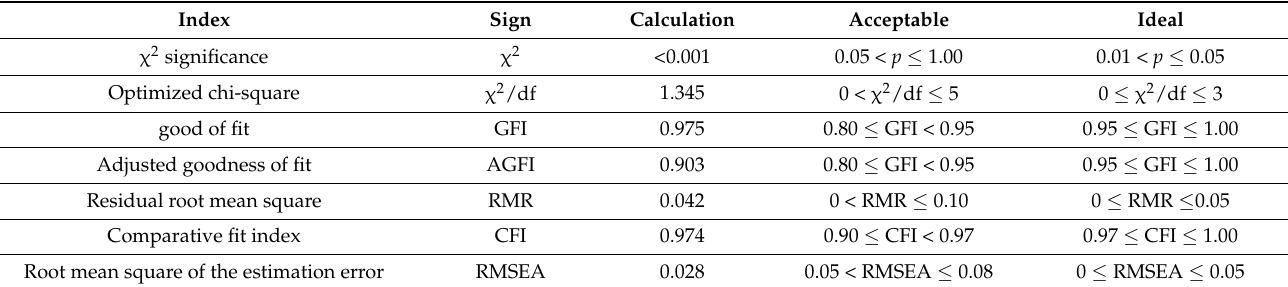
Table 3. The goodness of fit criteria of the questionnaire.